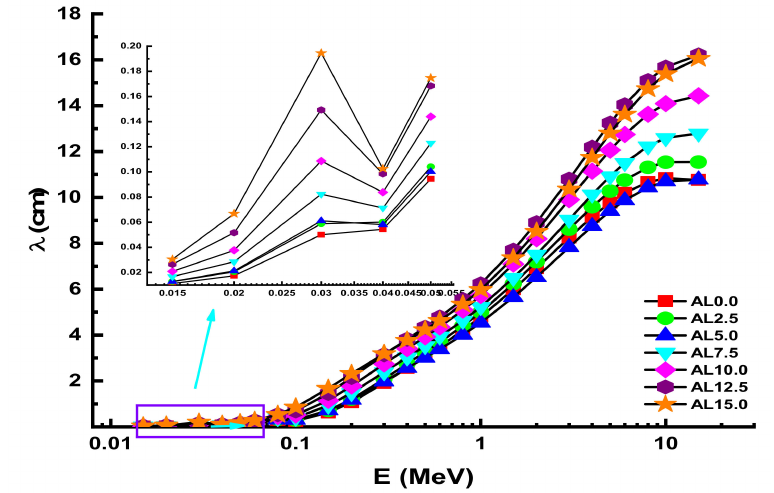
Figure 8. Variation of mean free path ( λ ) against photon energy for all glasses.